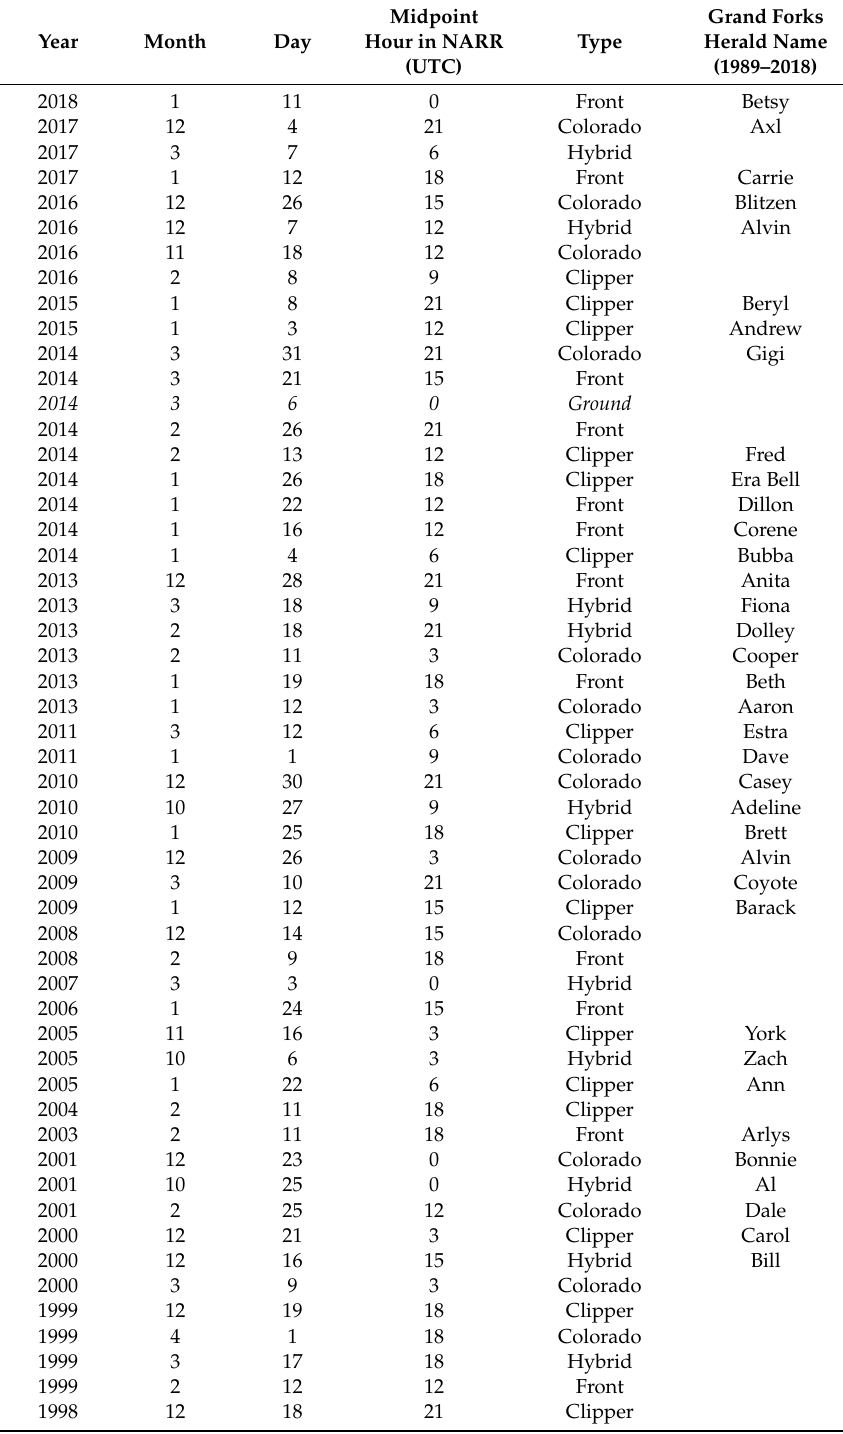
Table A1. Storm Data Blizzards in the Grand Forks NWSFO CWA 1979–1980 and 2017–2018. Italicized events were not included in the typing or SOM analyses. Blizzards named by the Grand Forks Herald but not listed within Storm Data are not provided. These events were most likely winter storms with visibility, wind speed, or duration not meeting NWS